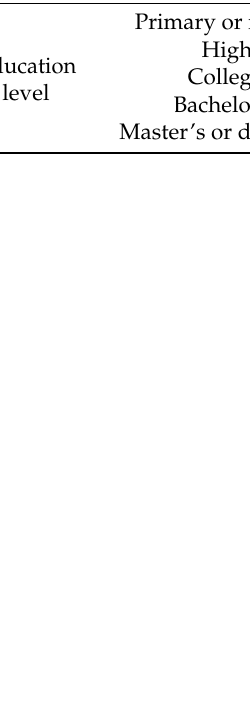
Table 2. Descriptive statistics of the main